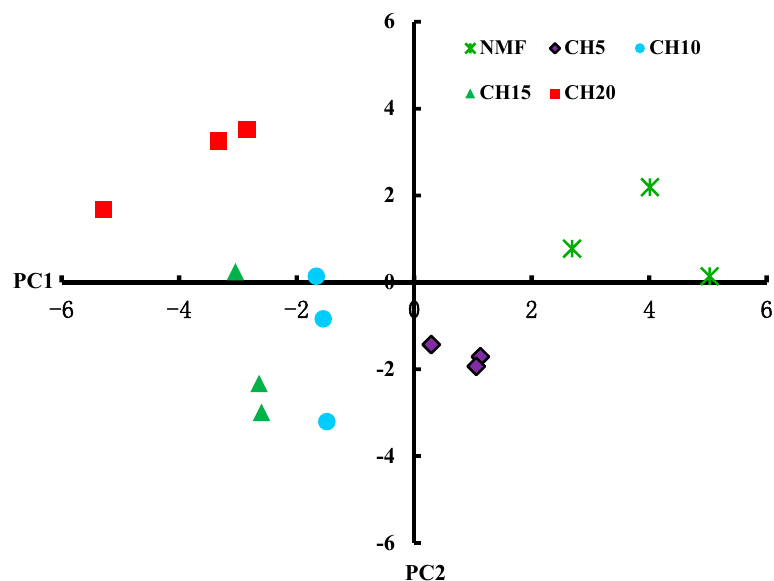
Figure 3. Principal component analysis of carbon source usage by soil microorganisms in Chinese hickory stands managed intensively for 5 (CH5), 10 (CH10), 15 (CH15), and 20 (CH20) years, and Chinese hickory–broad-leaved mixed forest (NMF) stands. Table 5. Microbial carbon source usage diversity in Chinese hickory stands managed intensively for 5, 10, 15, and 20 years, and in Chinese hickory–broad-leaved mixed forest. Stand Types